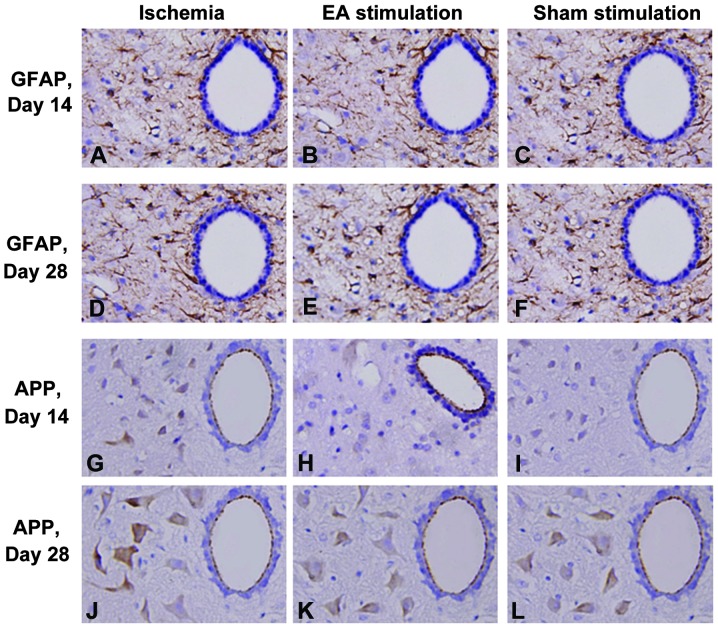
Effects of EA on the expression levels of GFAP and APP in the cervical spinal cord following cerebral ischemia in RHRSP rats; magnification, ×20. Representative immunohistochemical staining images showing (A–F) GFAP-positive and (G–L) APP-positive cell expression at day 14 and 28 after MCAO in the cervical spinal cord of rats that received sham or EA stimulation. EA, electroacupuncture; GFAP, glial fibrillary acidic protein; APP, amyloid precursor protein; RHRSP, stroke-prone renovascular hypertensive; MCAO, middle cerebral artery occlusion.